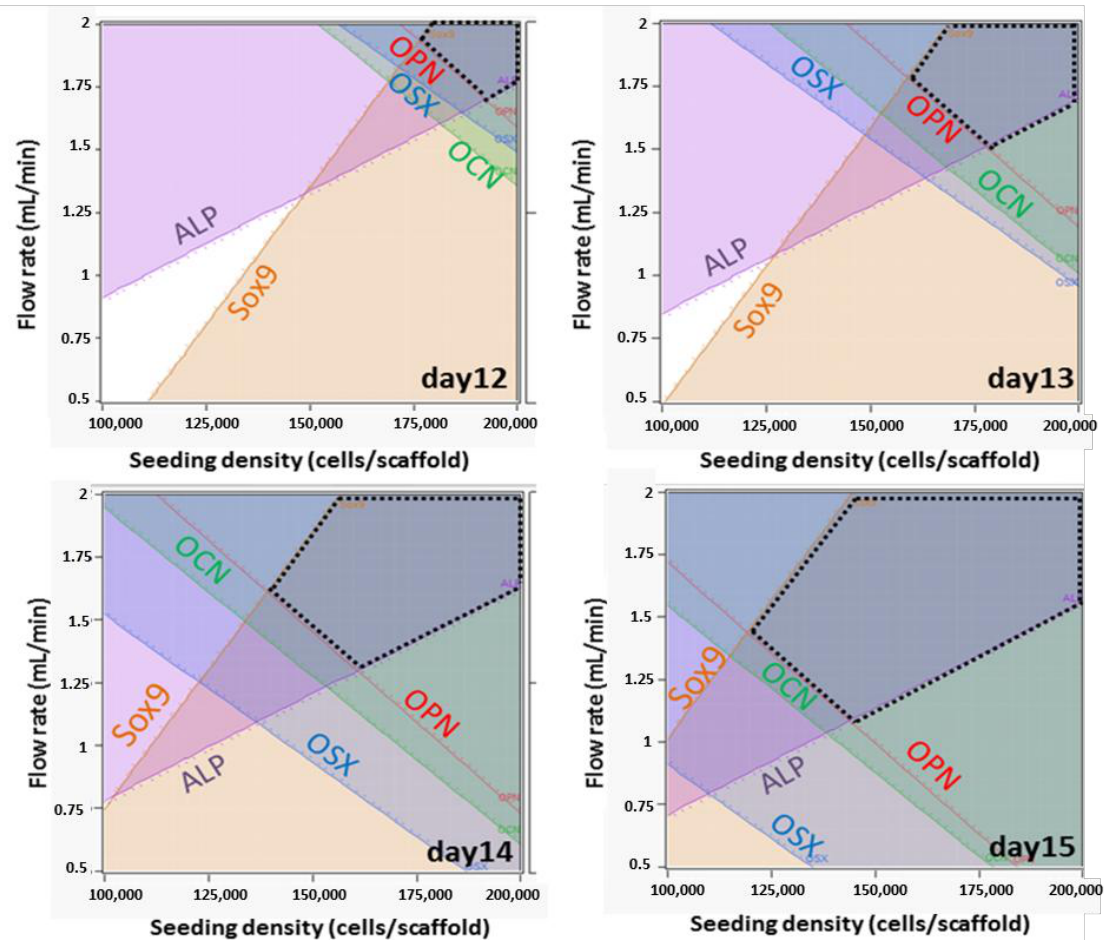
Figure 8. Development of a selected gene expression signature over culture time (as indicated by the dashed lines) in a perfusion bioreactor setup, as a function of flow rate and cell seeding